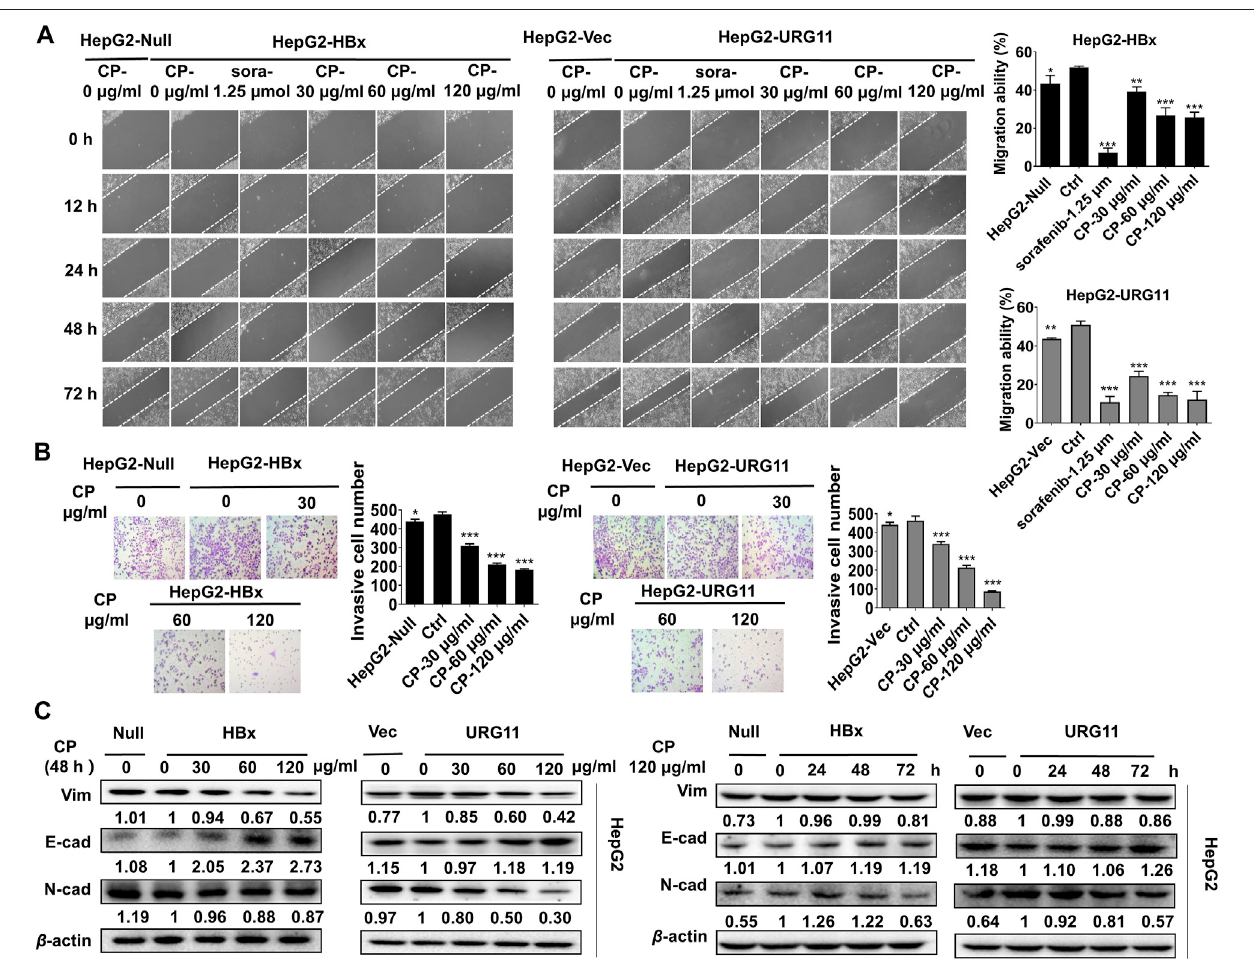
FIGURE 2 | CP inhibited migration and invasion of HBV-associated HCC. (A) HBV-associated cells including HepG2-HBx and HepG2-URG11 following CP administration and sorafenib treatment exhibited a signi fi cant delay in wound healing compared with that of control group. (B) CP treatment remarkably decreased the number of HBV-associated cells that migrated across matrigel and transwell chamber. (C) Western blot analysis showed that CP dramatically decreased expression levels of Vimentin and N-cadherin and increased E-cadherin level in both HepG2-HBx and HepG2-URG11 cells in a time-concentration dependent manner. All values represented the means ± SD ( n (cid:1) 3, * p < 0.05, ** p < 0.01, *** p <